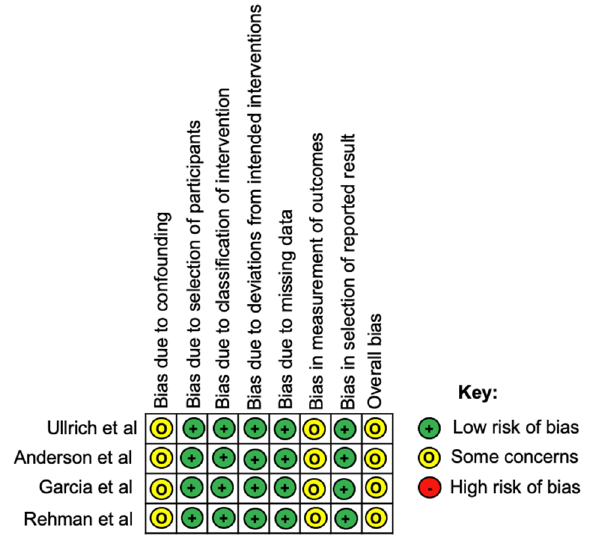
Figure 3. Risk of bias assessment according to the ROBINS-I tool.